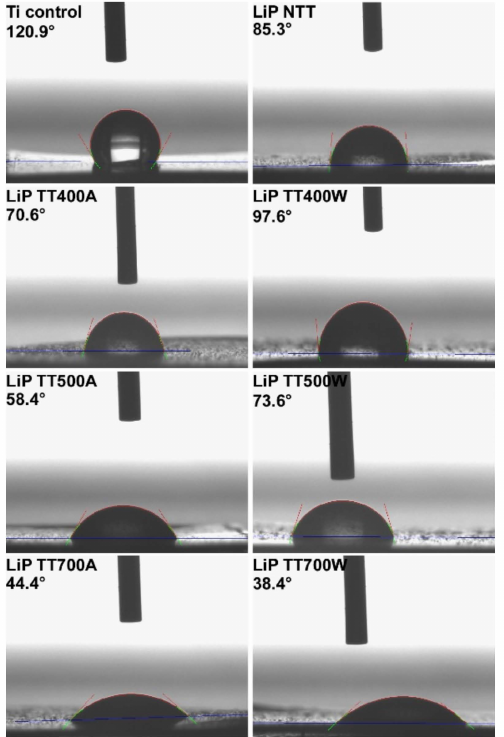
Figure 14. Representative images of the water droplets on control (Ti), NTT LiP and of those subjected to post-deposition thermal treatments (at different temperatures), in air and water-vapor